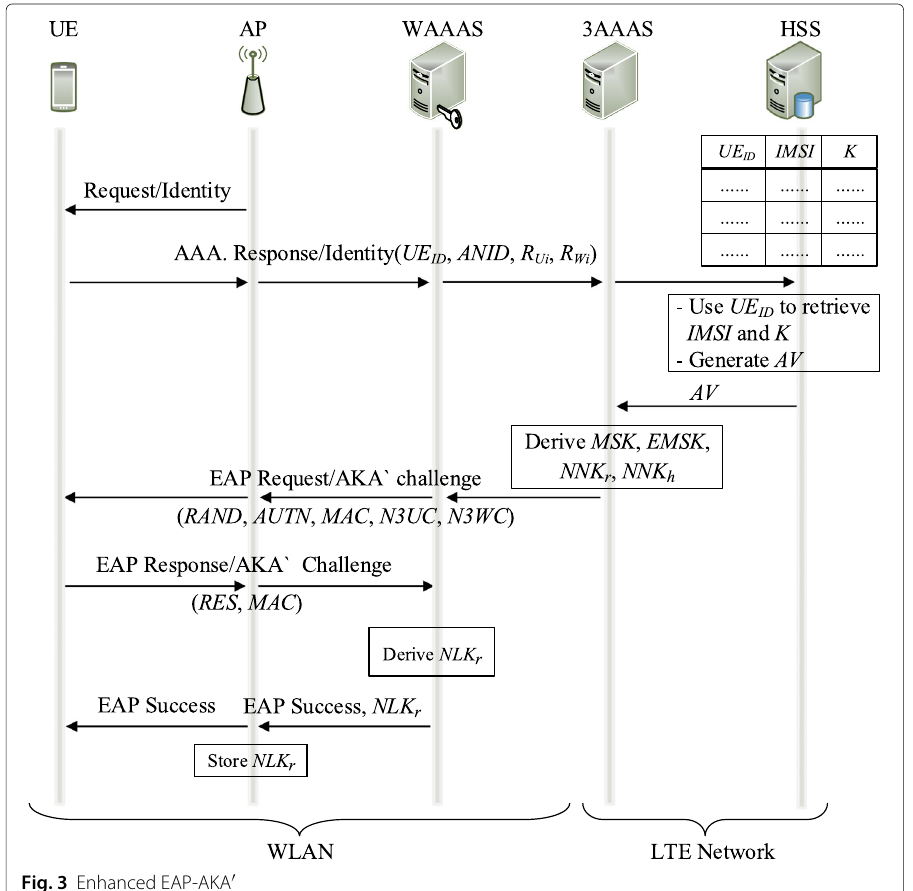
Fig. 3 Enhanced EAP-AKA